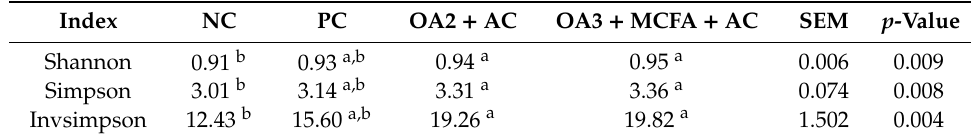
Table 6. E ff ect of dietary treatments on alpha diversity.